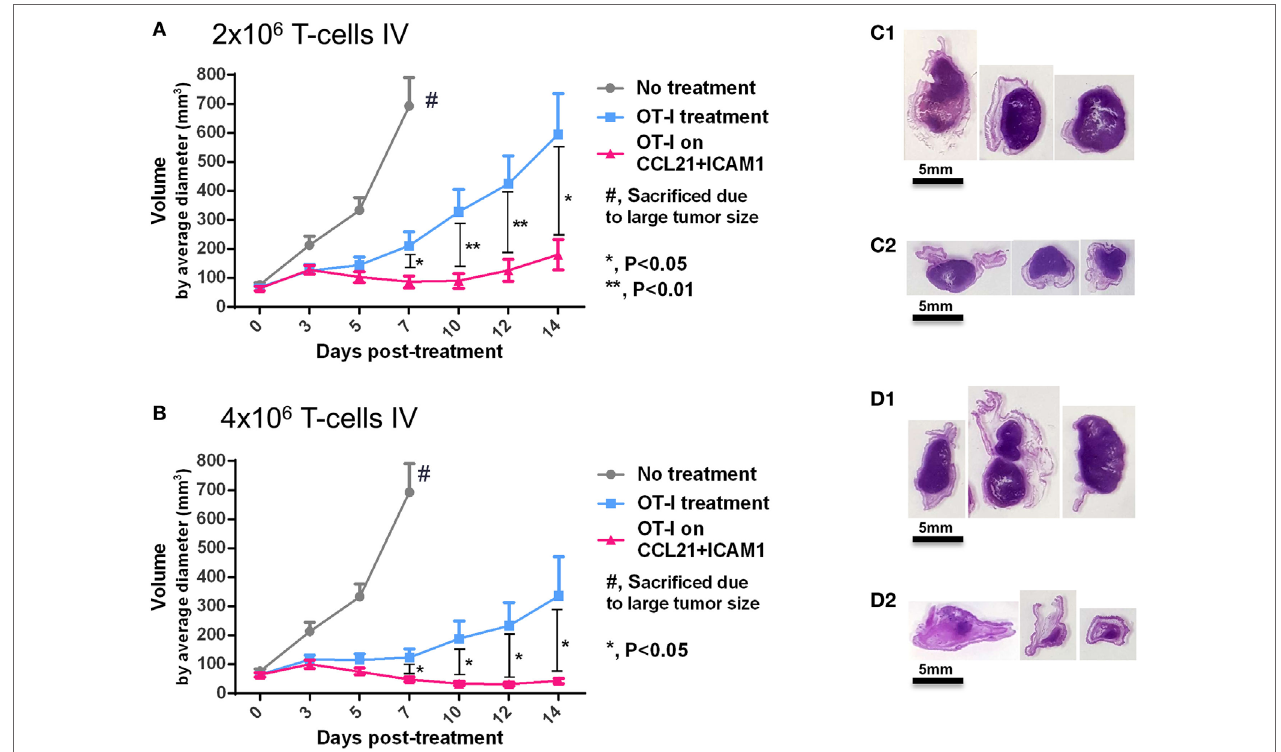
FigUre 7 | Substrate-immobilized CCL21 + intercellular adhesion molecule 1 (ICAM1) augment tumor suppression by CD8 + T-cells in vivo . (a,B) C57BL/6 mice were injected with 2 × 10 6 B16 cells expressing ovalbumin and GFP. Seven days later, tumor-bearing mice were split into treatment groups, according to similar tumor average size and distribution, and injected intravenously with 2 × 10 6 (a) or 4 × 10 6 activated OT-I T-cells (B) . Averages of measured tumor volumes are shown for either untreated mice (gray), or for mice treated with OT-I T-cells pre-cultured for 7 days on an uncoated substrate (blue), or on substrate-immobilized CCL21 + ICAM1 (pink). (c1–D2) Images of histology sections of three representative tumors of mice treated with 2 × 10 6 OT-I T-cells pre-cultured on uncoated substrates (D1) , or on substrate-immobilized CCL21 + ICAM1 (D2) ; or treated with 4 × 10 6 OT-I T-cells pre-cultured on uncoated substrates (e1) , or on substrate- immobilized CCL21 + ICAM1 coating (e2) . Scale bar: 5 mm. T-cells pre-cultured on substrate-immobilized CCL21 + ICAM1 suppressed tumor growth to a significantly greater extent than T-cells cultured on uncoated substrates. N = 10 mice per group. Error bars represent